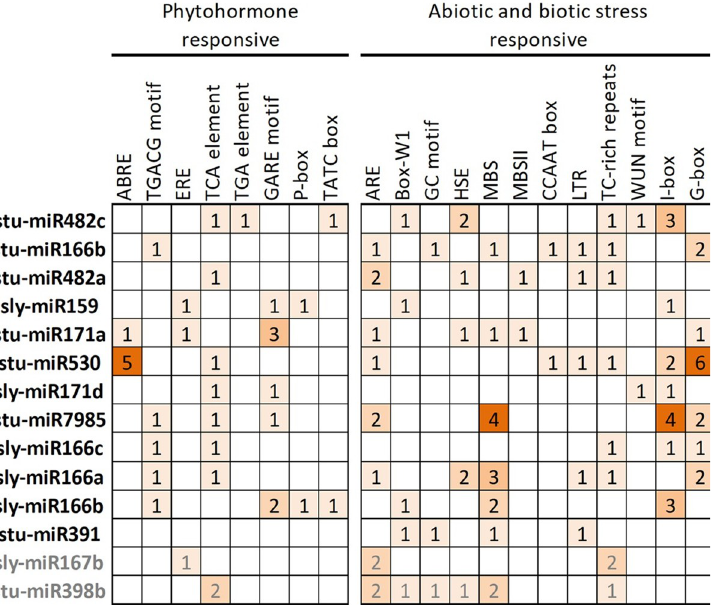
Fig 6. In silico identification of cis-elements in the promoters of KPhi differentially expressed miRNAs. The promoters of pre-miRNAs were analyzed in silico using the web available program PlantCARE (bioinformatics.psb. ugent.be/webtools/plantcare/html). Down-regulated and up-regulated miRNAs are shown in black and grey, respectively. The numbers represent total well characterized cis-acting elements per miRNA.